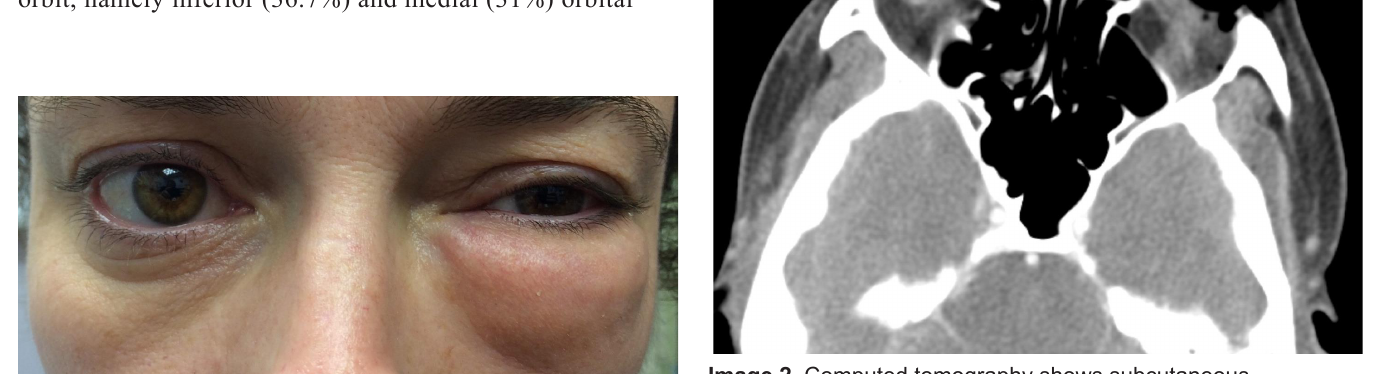
Image 2. Computed tomography shows subcutaneous emphysema around the left orbit